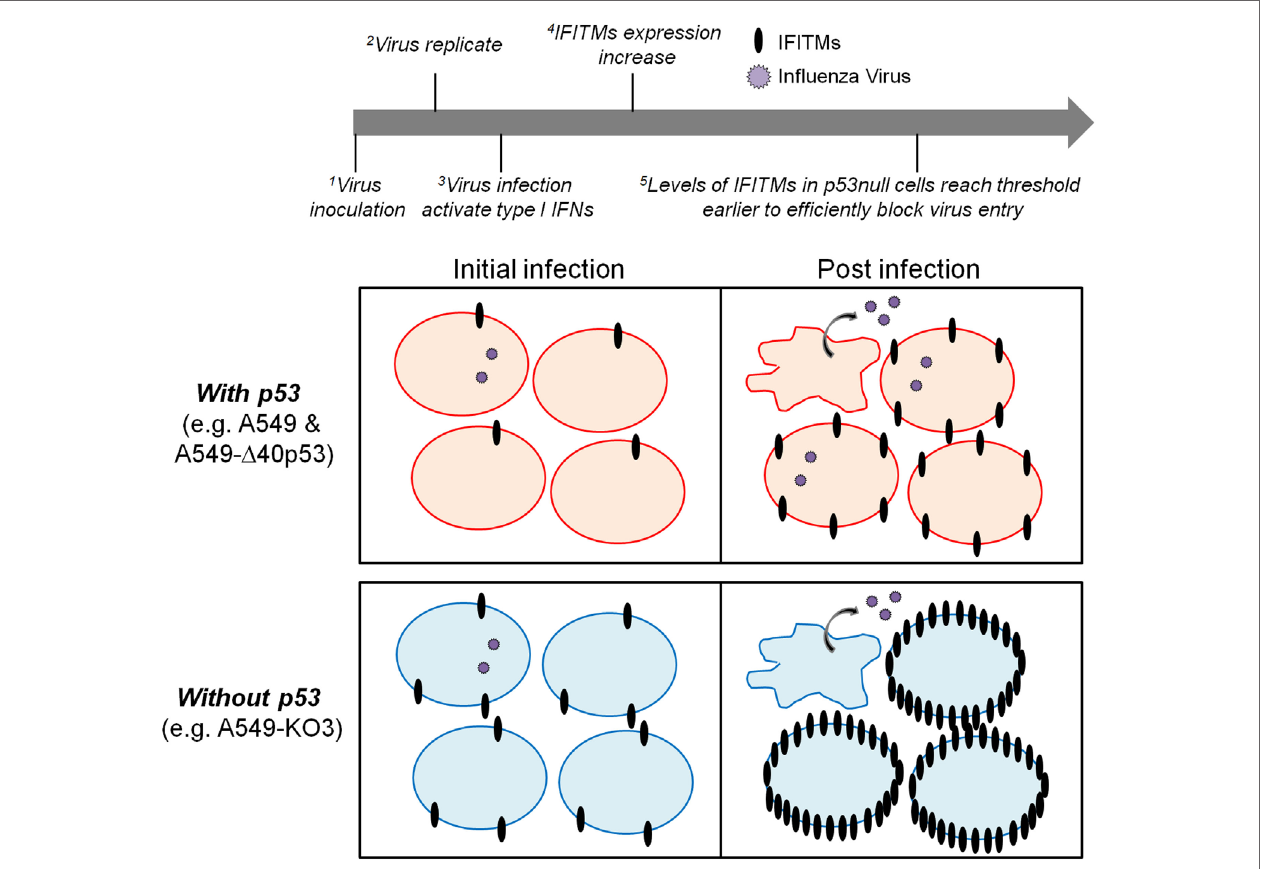
FigUre 9 | A proposed model of p53 and interferon-induced transmembrane protein (IFITM) cross-regulation of cellular IAV susceptibility. During the initial influenza virus inoculation (initial infection), both p53-sufficient (top left panel) and -deficient cells (bottom left panel) express extremely low levels of IFITMs and hence are equally susceptible to virus infection. With the progression of virus replication (post-infection), the type I interferon pathways are activated to increase the expression of IFITMs. In cells expressing p53, IFITMs could not be efficiently upregulated so that the viral particles are still able to infect the neighboring cells (top right panel). While in cells without p53 expression, IFITMs could be more efficiently upregulated so that the threshold will be reached earlier to block the viral infectivity successfully (bottom right